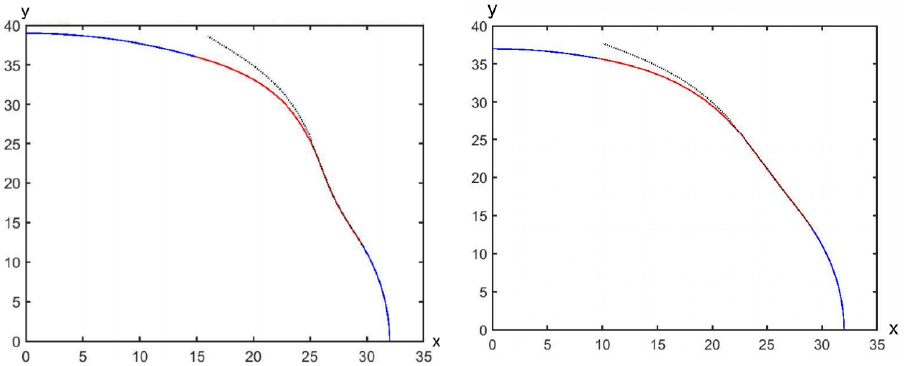
Figure 7. Stator cavity transition curve optimization comparison chart.